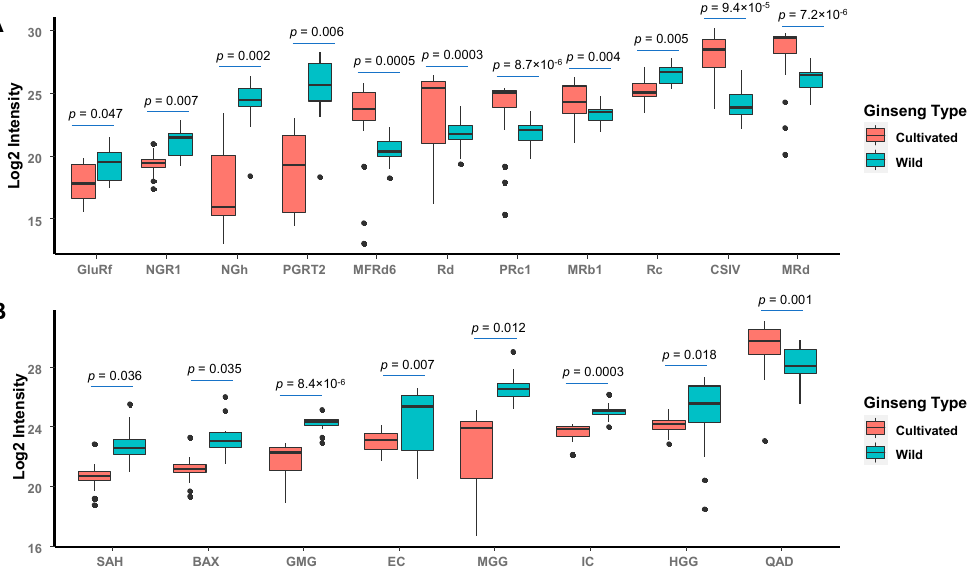
Figure 5. Comparison of identified marker ginsenoside ( A ) and non-ginsenoside ( B ) compounds in wild and cultivated ginseng samples. The semi-quantification was performed based on the normalized ion intensity obtained from HRMS. Black dots are outliers.